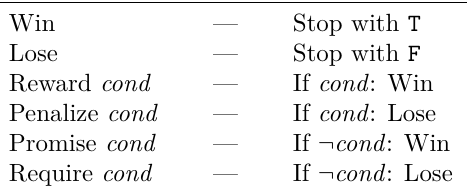
Table 1: Macros for game